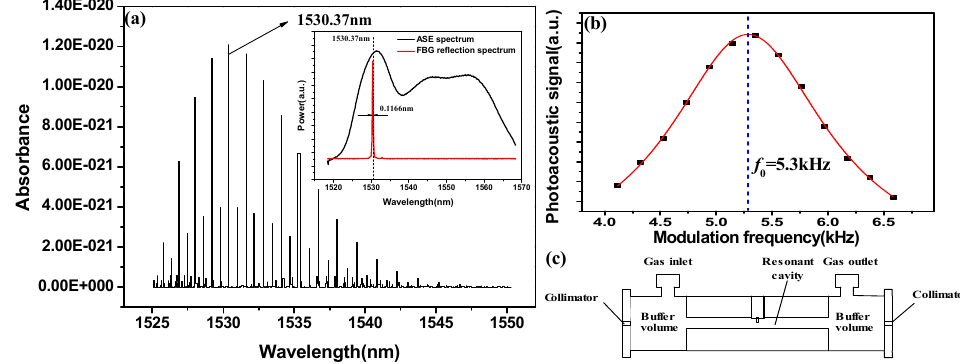
Figure 2. ( a ) C 2 H 2 absorption lines in C band. Inset: ASE spectrum and reflection spectrum of the custom-made FBG; ( b ) Resonance profile of the PAS cell: resonant frequency, 5300 Hz; ( c ) Schematic of the PAS cell.